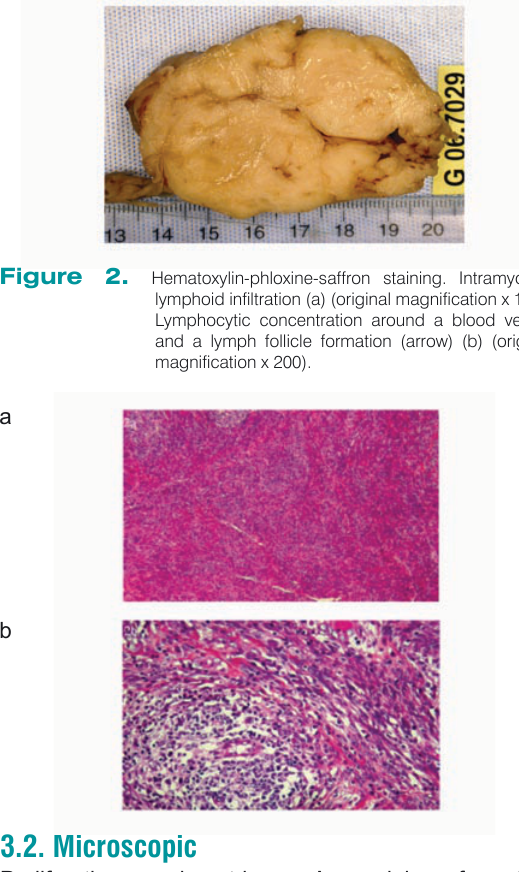
Figure 1. Macroscopic appearance of the leiomyoma nodule.